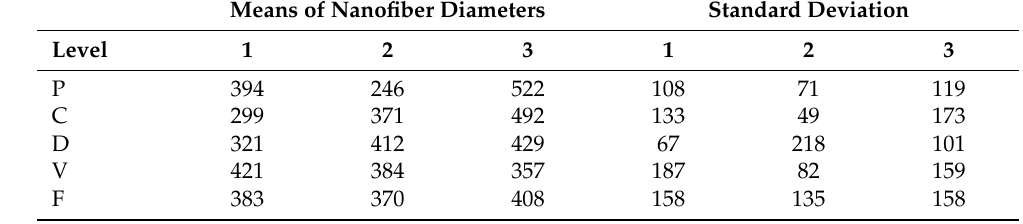
Table 3. Means of nanofiber diameters (nm) and standard deviation (SD).